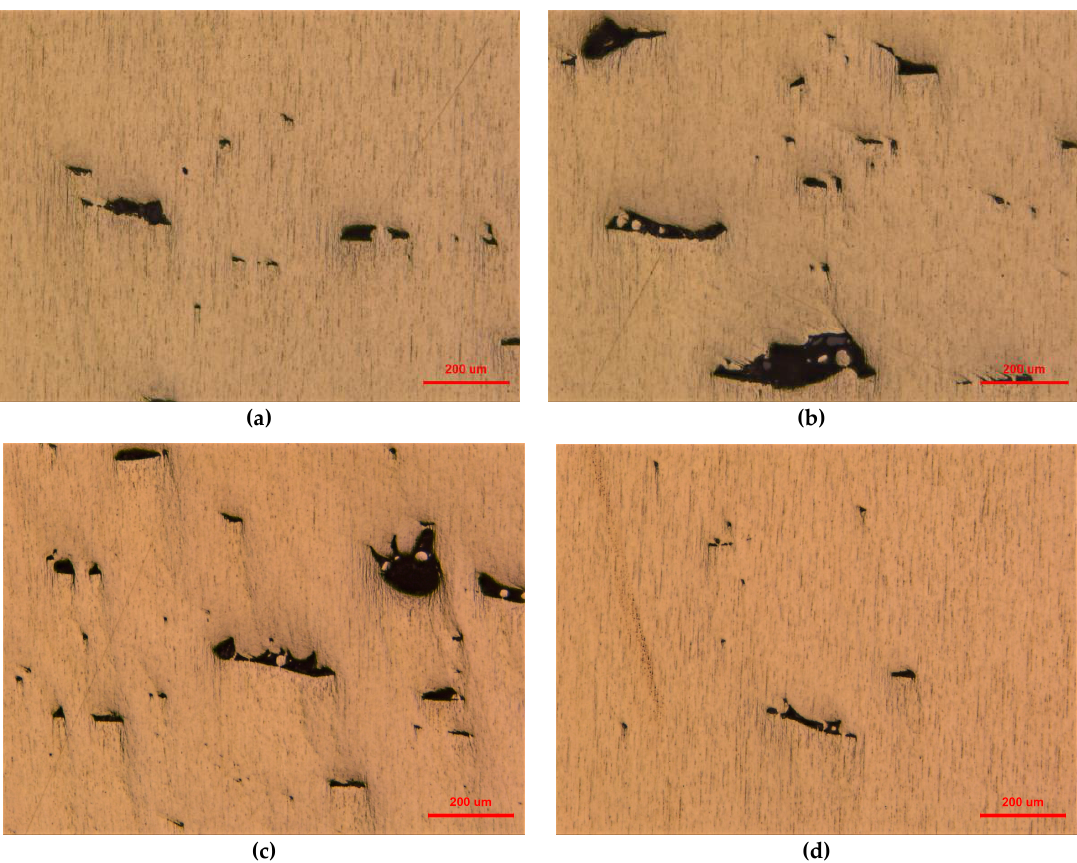
Figure 9. Microscopic morphology of the first part printed by the first scanning strategy ( a ), second part printed by the first scanning strategy ( b ), first part printed by the second scanning strategy ( c ), and second part printed by the second scanning strategy ( d ), respectively.